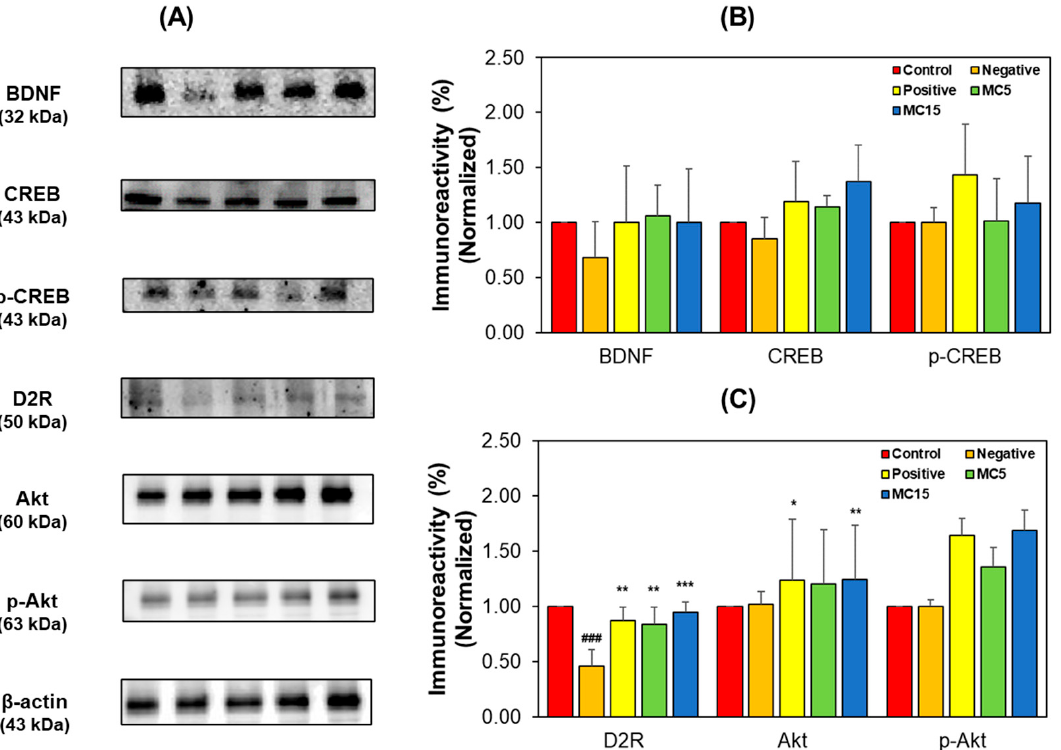
Figure 6. Western blotting of CREB, p-CREB, BDNF, Akt, p-Akt, and D2R in the hippocampus tissues. Western blots ( A ), and levels of immunoreactivities for BDNF, CREB, and p-CREB ( B) and for D2R, Akt, and pAkt ( C ). C, control; N, negative control (scopolamine-treated); P, positive control (scopolamine + donepezil treated); MC5 and MC15, doses of the compound MC (scopolamine + 5 and 15 mg/kg of MC, respectively). Data are presented as mean ± SEM. ### p < 0.001, compared to the control group; * p < 0.05, ** p < 0.01 and *** p < 0.001, compared to the scopolamine-treated group. In SH-SY5Y cells, the expression levels of BDNF, p-CREB, D2R, and p-Akt in the